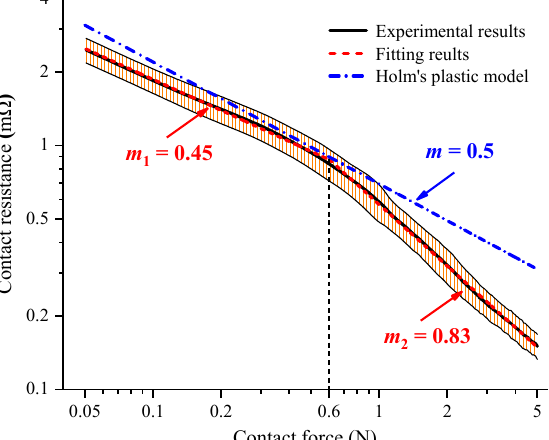
Figure 6. The variation in contact resistance as a function of the load force for AgSnO 2 (12) contacts with bright surfaces.